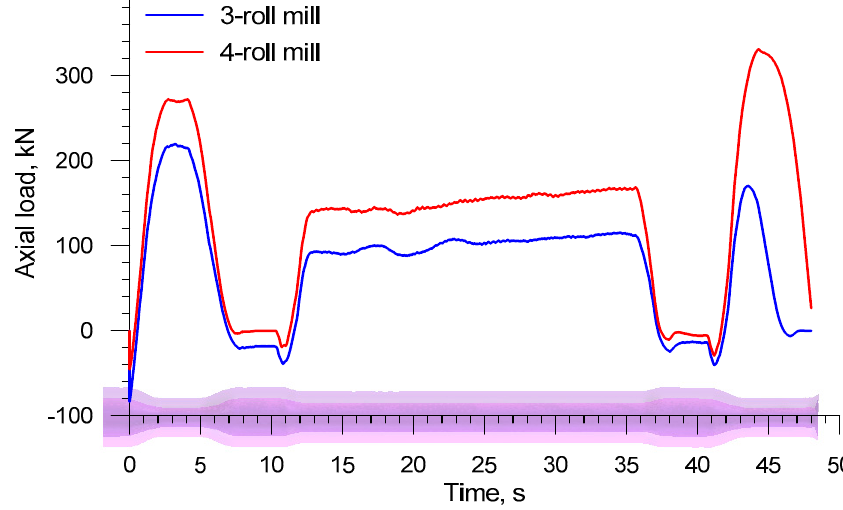
Figure 19. Axial load on the chuck in skew rolling hollow axles in 3- and 4-roll mills.